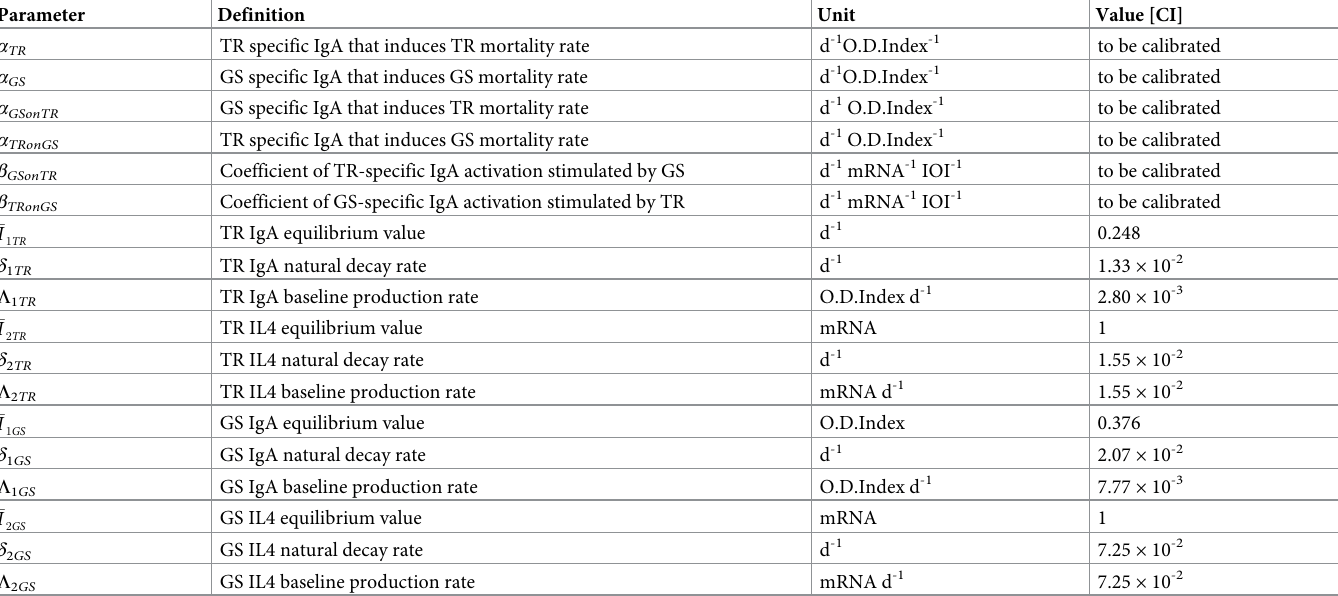
Table 3. Dual infection: Model parameters, definitions, dimensions and available values for both T. retortaeformis (TR) and G. strigosum (GS); model parameters that are not reported in the table are assumed to be equal to single-infection values (see Table 1). Parameter